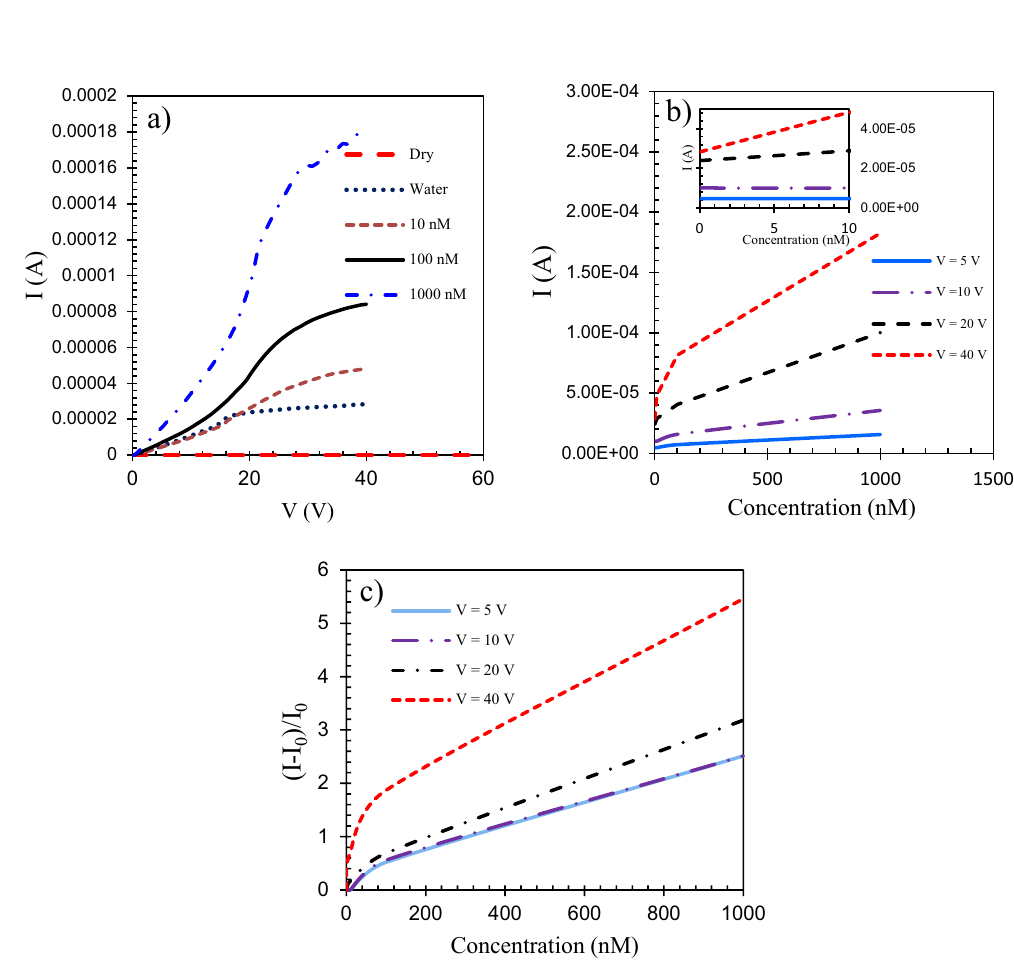
Figure 11. The electrical characteristic (I-V) of the resistive sensor in the presence of glucose from 10 nM to 1 µM. ( a ) I as a function of V. ( b ) I as a function of glucose concentrations for different voltages. ( c ) Sensor response (I n − I o )/I o as a function of glucose concentrations for different